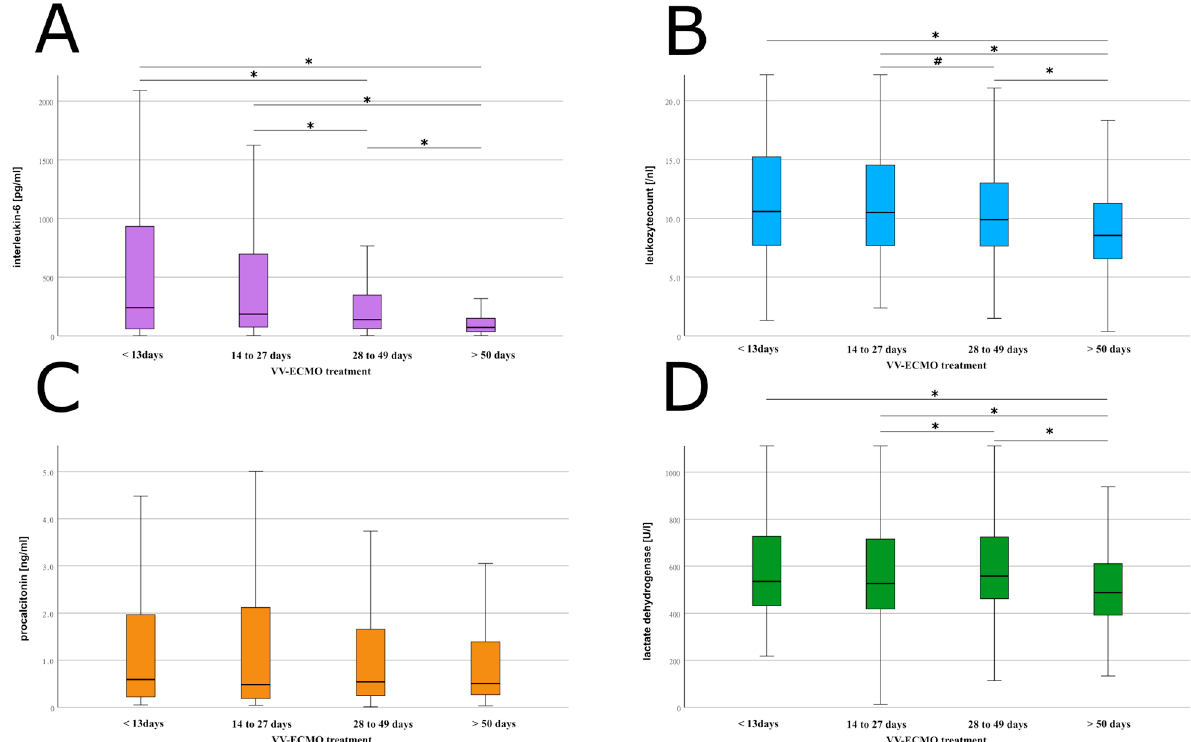
Figure 2. Laboratory infectious parameters. Box and whisker plots of the daily results of the laboratory infectious parameters, subdivided into the included patients with VV-ECMO therapy according to the duration of therapy. ( A ) Illustration of the interleukin-6 values determined twice a day with representation of the significant decrease in values in association with a prolonged VV-ECMO treat- ment. ( B ) Visualization of the leukocyte count with corresponding significance levels. ( C ) Plots of the daily determined procalcitonin levels, without any significant difference. ( D ) Illustration of the lactate dehydrogenase values and the consequent significant levels. Abbreviations: l, litre; mg milligram; ml, millilitres; ng, nanogram; pg, picogram; U, Units; VV-ECMO, veno-venous Extracorporeal Membrane Oxygenation. * p < 0.01, # p <